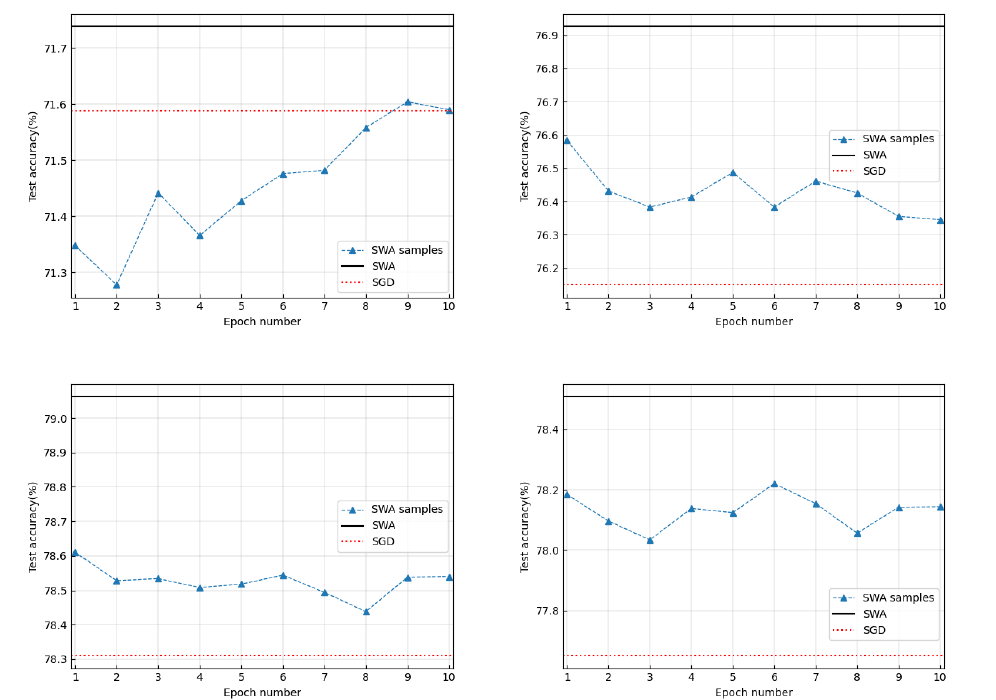
Figure A2. Ablation study using the ImageNet dataset. The legends are defined in the same way as in Figure 1. The top left, top right, bottom left, and bottom right panels show results corresponding to VGG16, ResNet-50, ResNet-152, and DenseNet-161, respectively. Note that SWA began based on the pre-trained models in Pytorch. Therefore, the horizontal axis label initialized with epoch